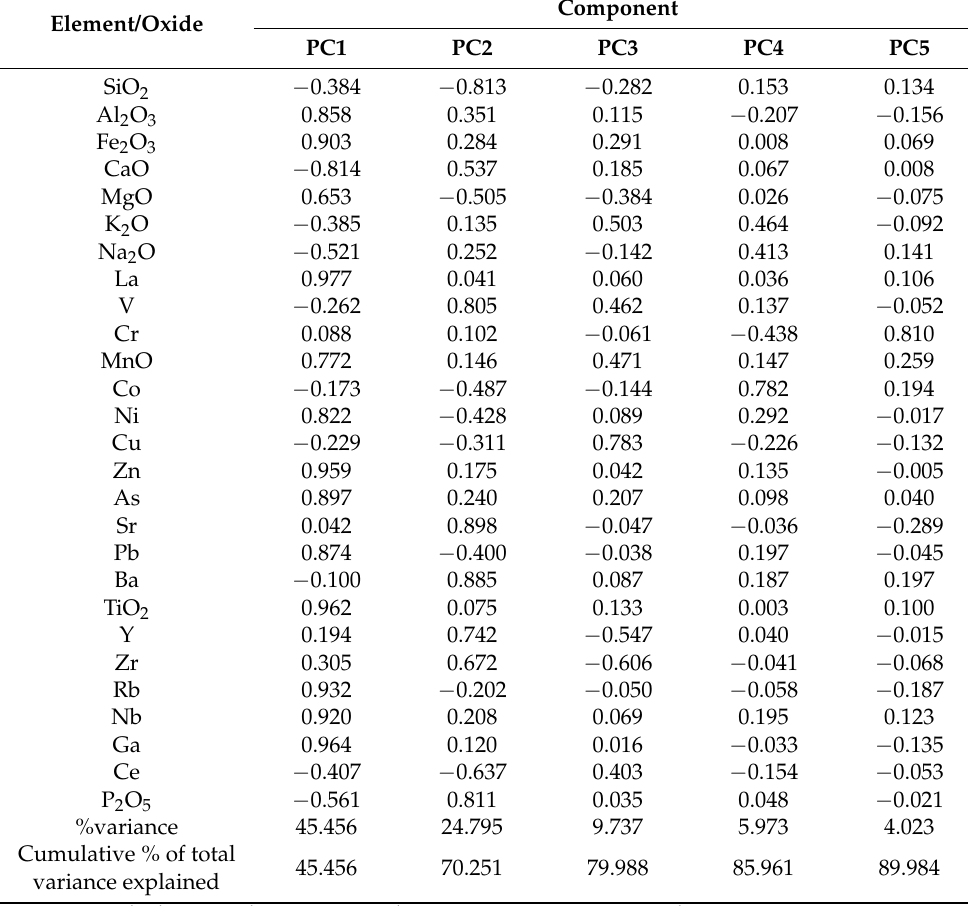
Table 4. Principal components (PCs) loading values for the contents of elements/oxides in aeolian sediments in the Dinggye